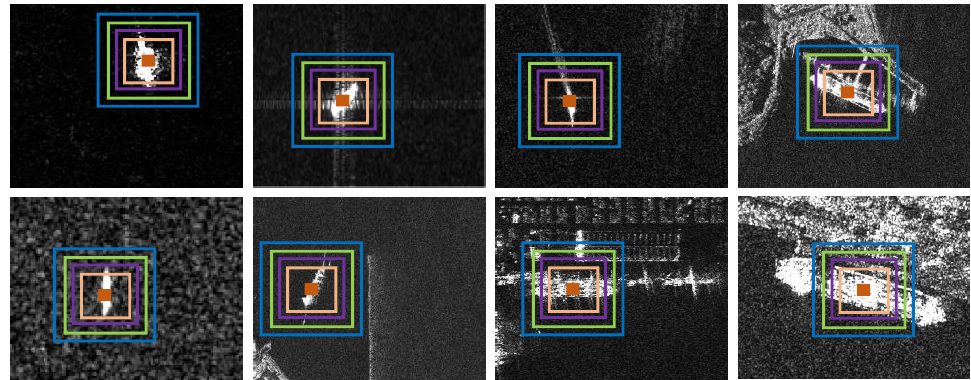
Figure 5. Multi receptive-field feature response of SAR ships.